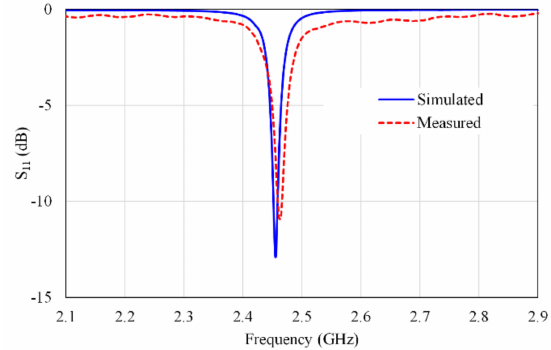
Figure 8. Simulated and measured S 11 .